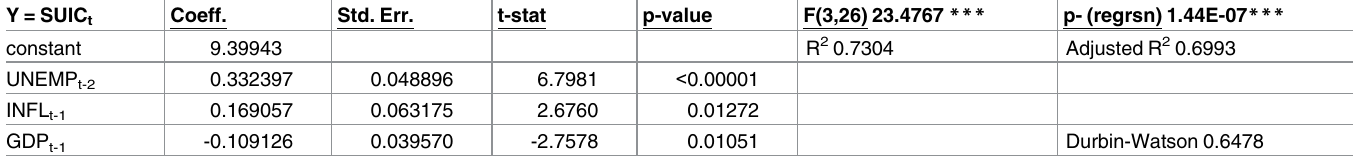
Table 1. Suicides: Model #1 OLS regression between the lagged US unemployment rate, inflation rate, GDP growth rate and CDC- provided annual suicide rates (Y-variable). All p-values are significantat the 0.015 level. The overall regressionF-stat is 23.48 and significantat the 0.015 p-value.The Dur- bin-Watson test value of 0.6478 indicatesa slight positive autocorrelation in the regression residuals. The adjusted R 2 indicatesthat 69.93%of the variation in the suiciderate is explained by the three independent variables. Annual rates are since 1980. Data from [9], [10]. Y = SUIC t Coeff.